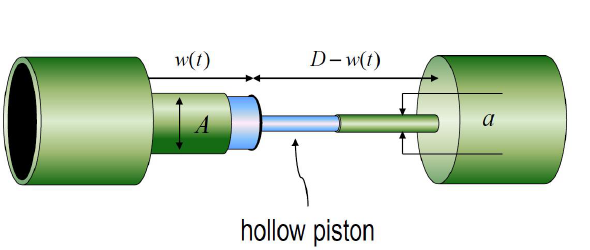
Fig. 5: Pipe model of a memristor. Here, the thick tube, A represents the high conductive part of the memristor, whereas the thin tube, a represents the high resistive part. Depending on the direction of the water flow, the piston is pushed either to the left or to the right. Hence, the net resistance of the memristor is altered when water is flowing through it. This model has also earlier been presented in [4]. Courtesy of C.